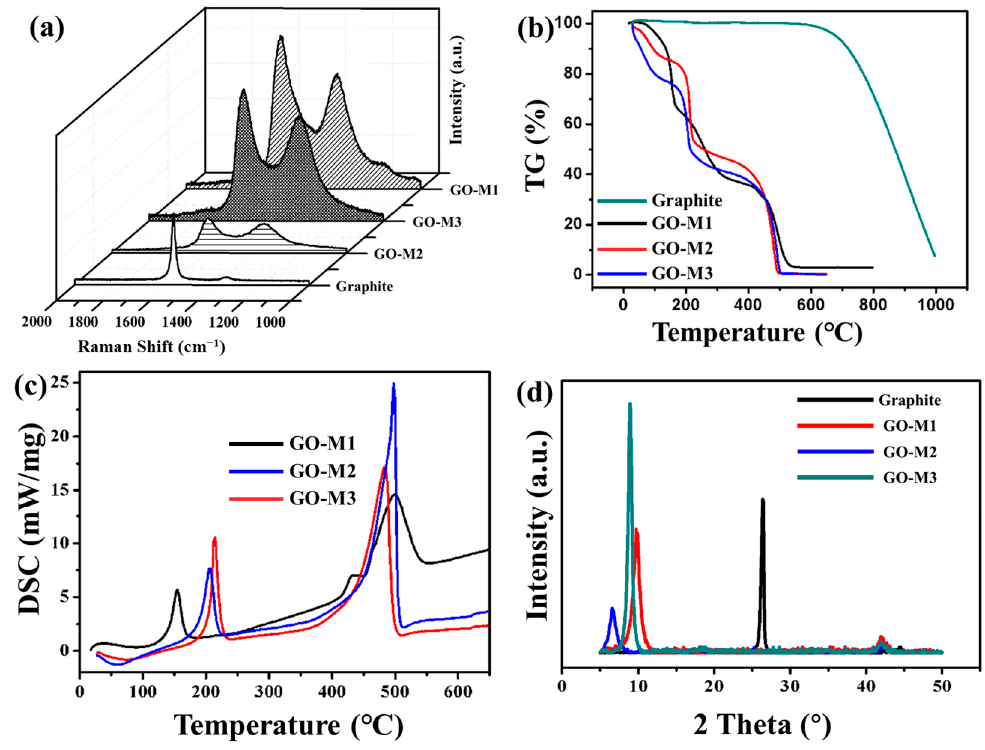
Figure 3. RS patterns ( a ), TG curves ( b ) and XRD patterns ( d ) of graphite powder and three types of GOs and DSC curves of GOs ( c ). Table 2. I D /I G values of graphite powder and three types of